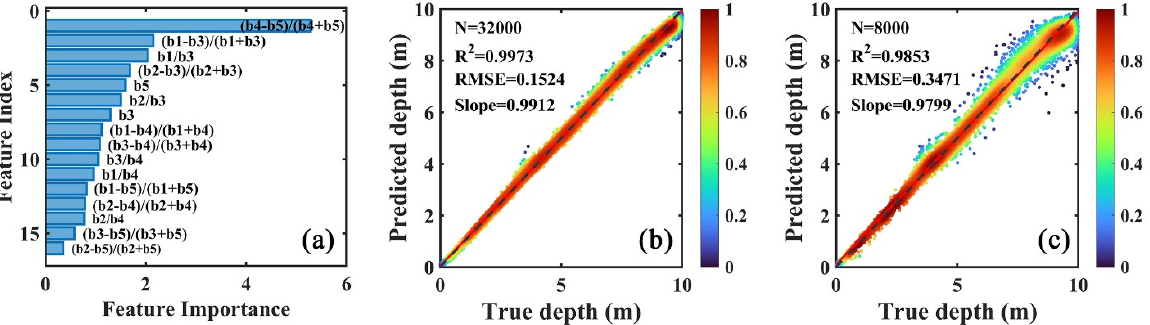
Figure 7. ( a ) Importance ranking of selected spectra indices; ( b ) Density scatter plots between true depth and model predicted depth for training; ( c ) Density scatter plots between true depth and model predicted depth for independent validation. The dotted line is the 1:1 line, and the color of the dots represents the density.